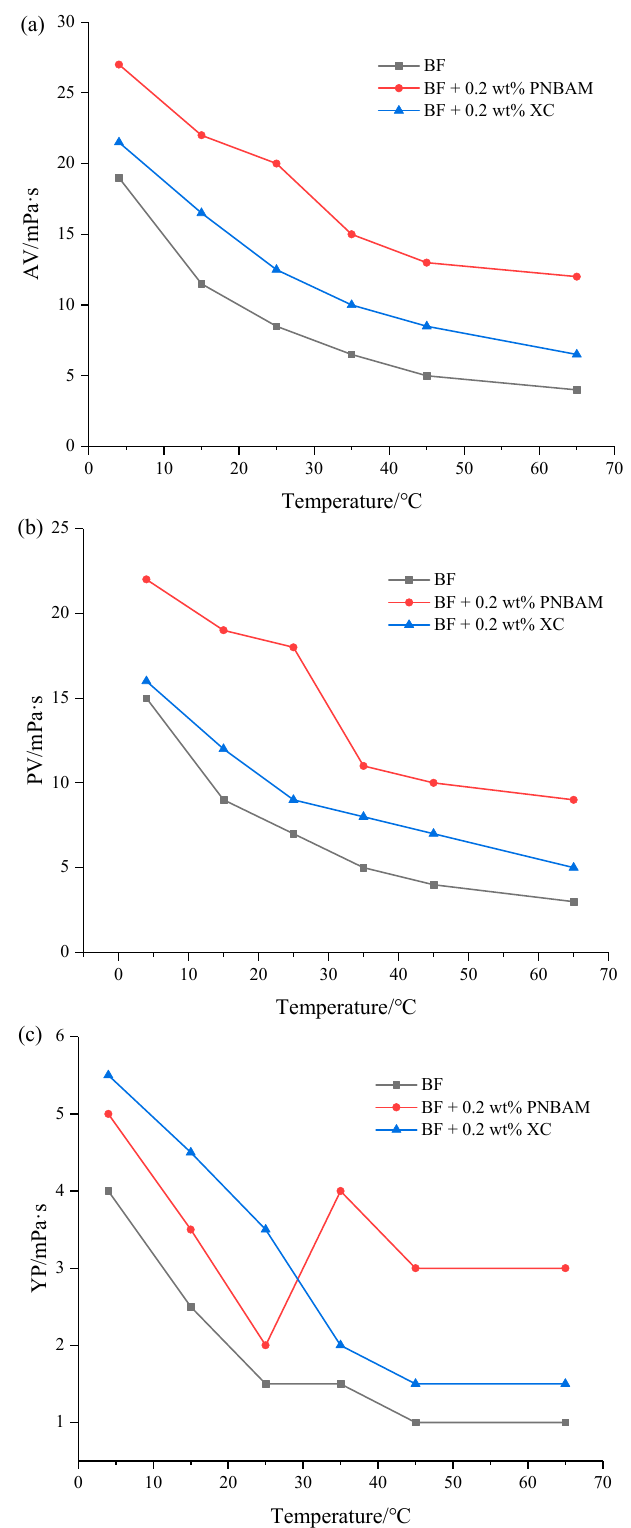
Figure 4. Effects of XC and PNBAM on AV ( a ), PV ( b ), YP ( c ) of BF after aging at 120 °C for 16 h where AV is the apparent viscosity (mPa·s), PV is the plastic viscosity (mPa·s), and YP is the yield value (Pa).